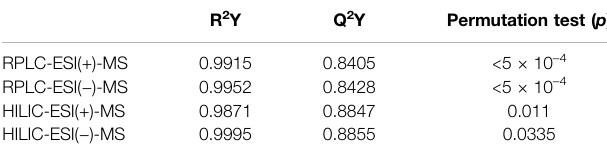
TABLE 2 | R 2 Y, Q 2 , and permutation ( p ) values for the evaluation of statistical signi fi cance. R 2